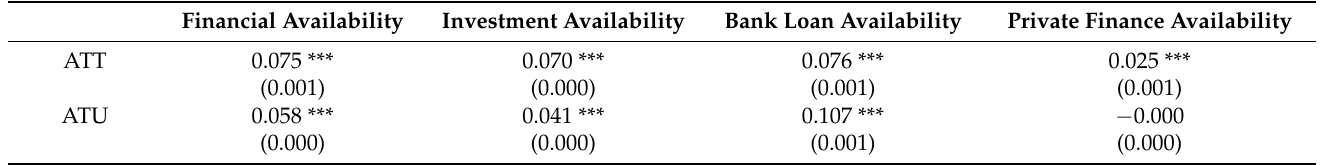
Table 12. Digital payment adoption and financial availability (estimated by ESR